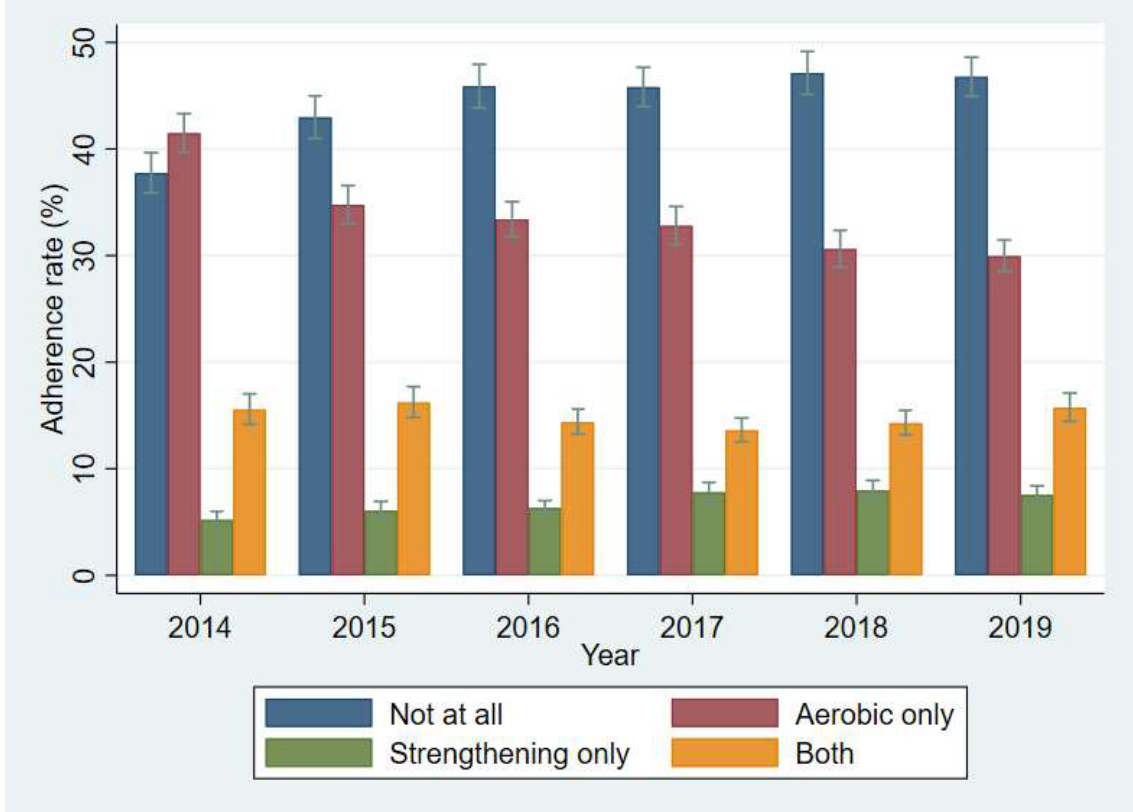
Figure 1. Trends of the adherence rate to the PA guidelines by survey year.